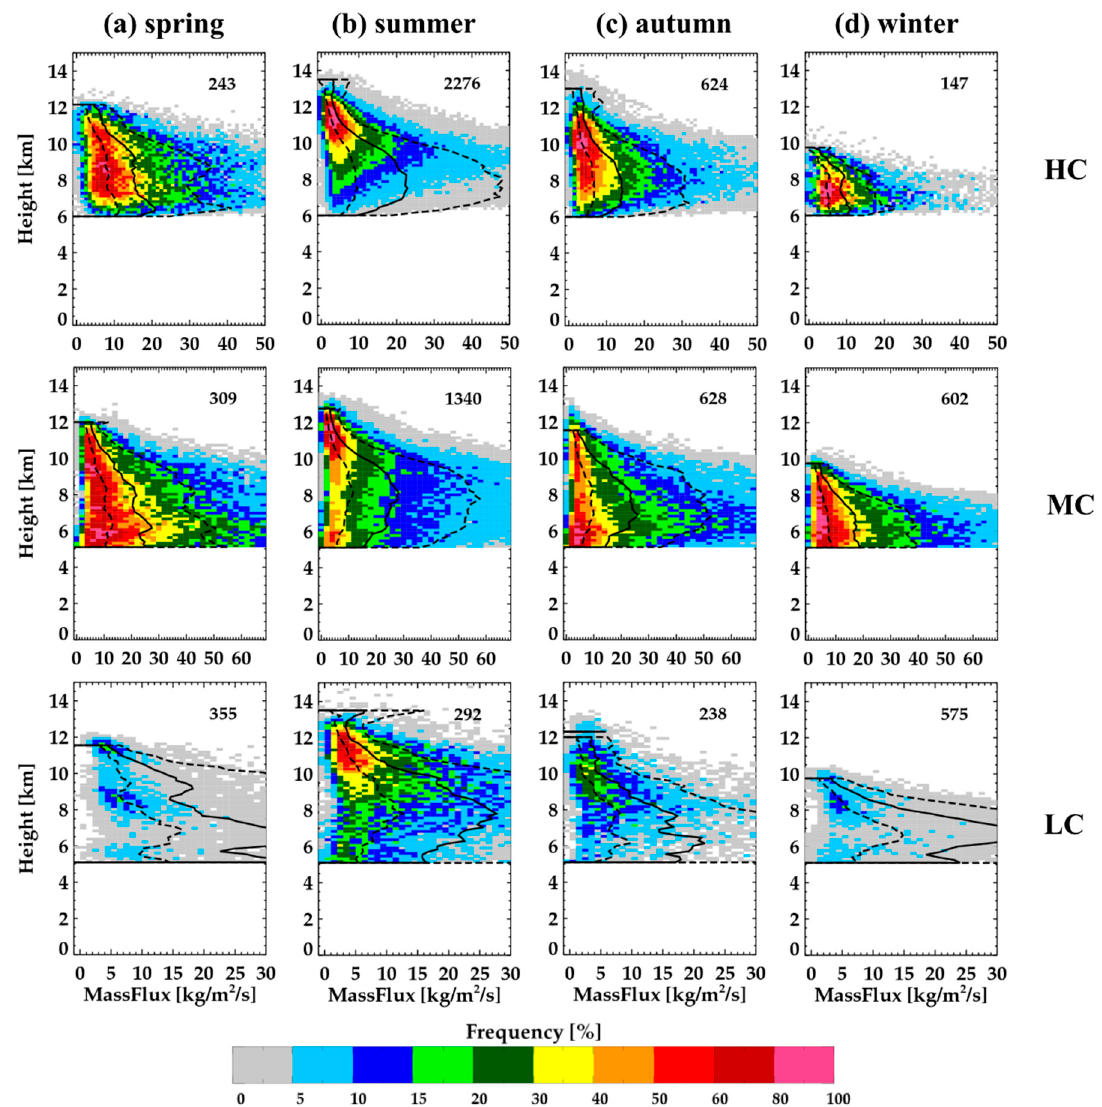
Figure 14. The same as in Figure 12 except for the CFADs of mass flux in the vertical direction. The median and quantiles (25% and 75%) are shown in the solid and dashed lines. ( a ) Spring, ( b ) summer, ( c ) autumn, and ( d ) winter.